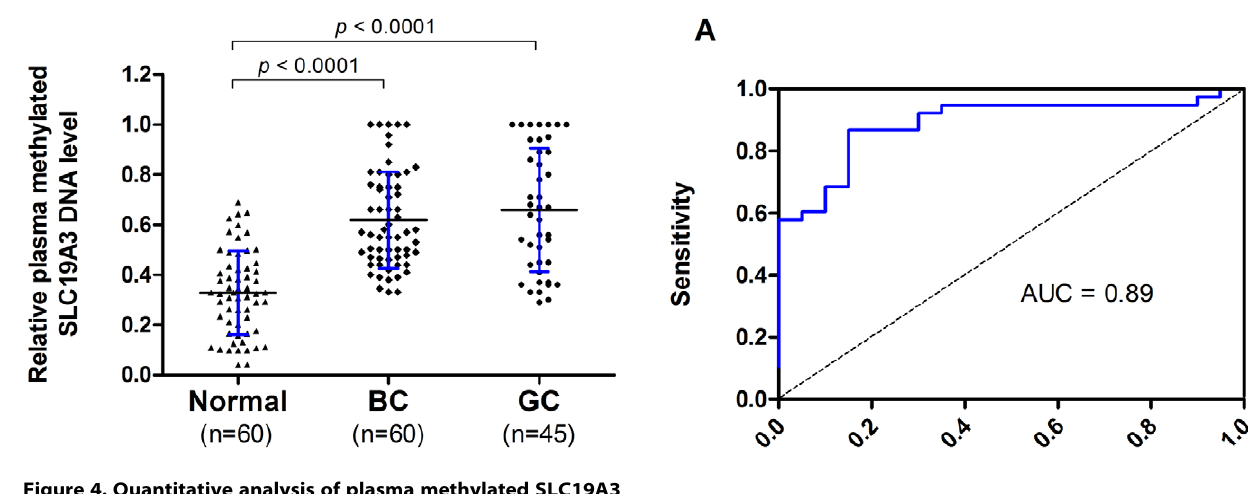
Figure 4. Quantitative analysis of plasma methylated SLC19A3 DNA on a group (n=165) of plasma samples by MSRED-qPCR. Scatter plots of plasma levels of methylated SLC19A3 DNA in 60 healthy normal subjects, 45 gastric cancer (GC) and 60 breast cancer (BC) patients. Plasma level of methylated SLC19A3 DNA is expressed as 2 D Ct(undigest-digest) . D Ct (undigest-digest) is calculated by subtracting the Ct values of digested plasma DNA from the Ct values of undigested plasma DNA. Since Ct of undigest should be # Ct of digest, the expression level is ranging from 1 to 0. The horizontal black lines denote the means. The blue errors bars denote the 6 standard deviations (SD). Statistically significant differences were determined using Mann-Whitney U tests, P , 0.0001.